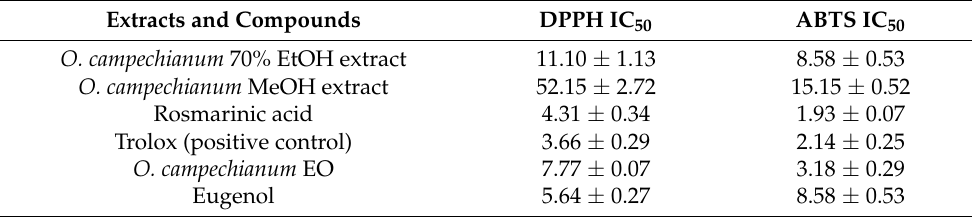
Table 3. DPPH and ABTS IC 50 ( µ g/mL) of O. campechianum extracts, EO, and main compounds. Extracts and